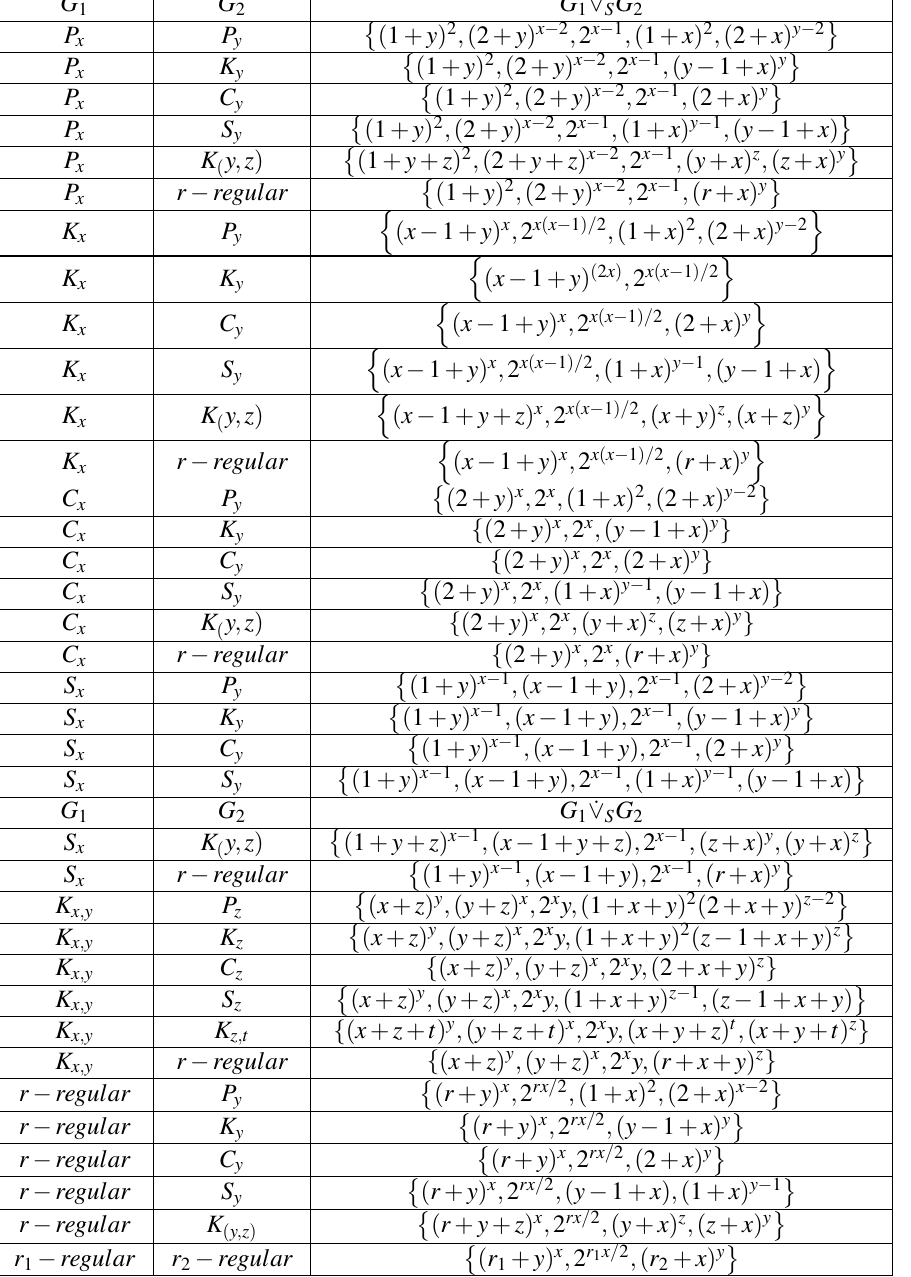
Table 2 Degree sequence of subdivision for path, complete graph, cycle, star, complete bipartite and r − regular